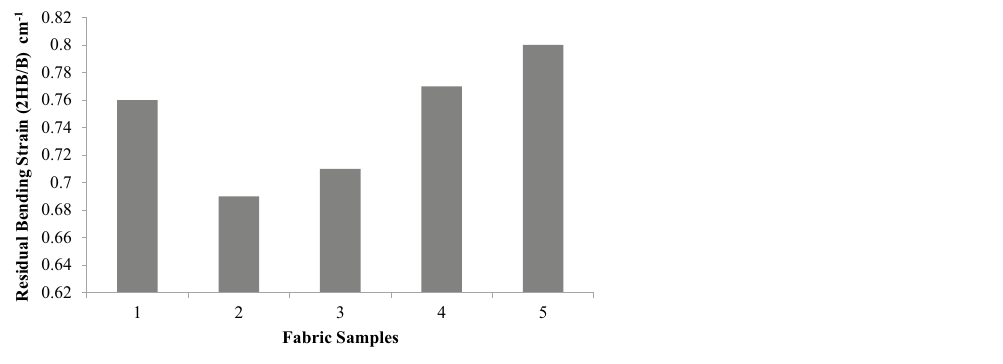
Figure 7. Residual bending strain